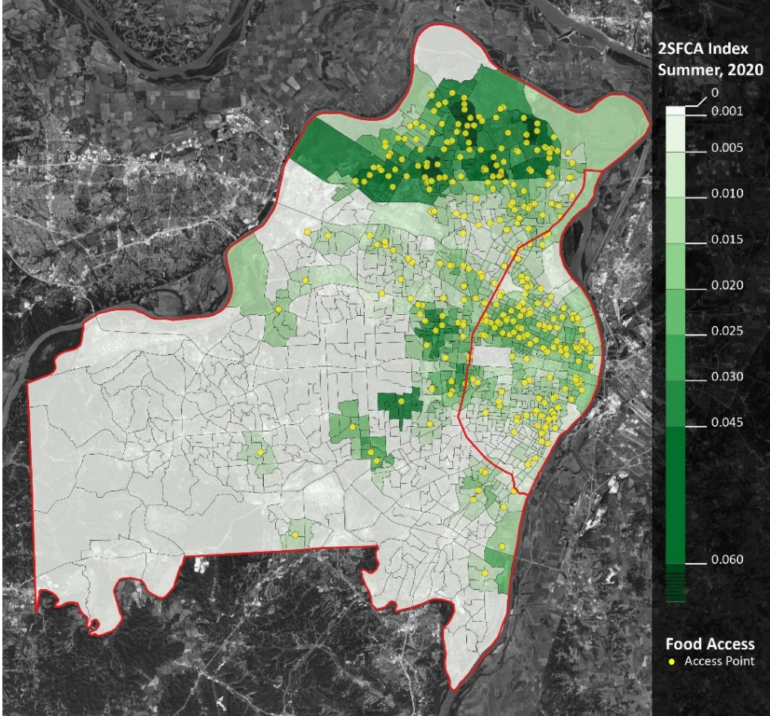
Figure 6. Meal accessibility (2SFCA): summer 2020. Notes: St. Louis City is the area east of the red line. St. Louis County is the area west of the red line. Yellow dots represent meal access points. Darker shades of green represent greater